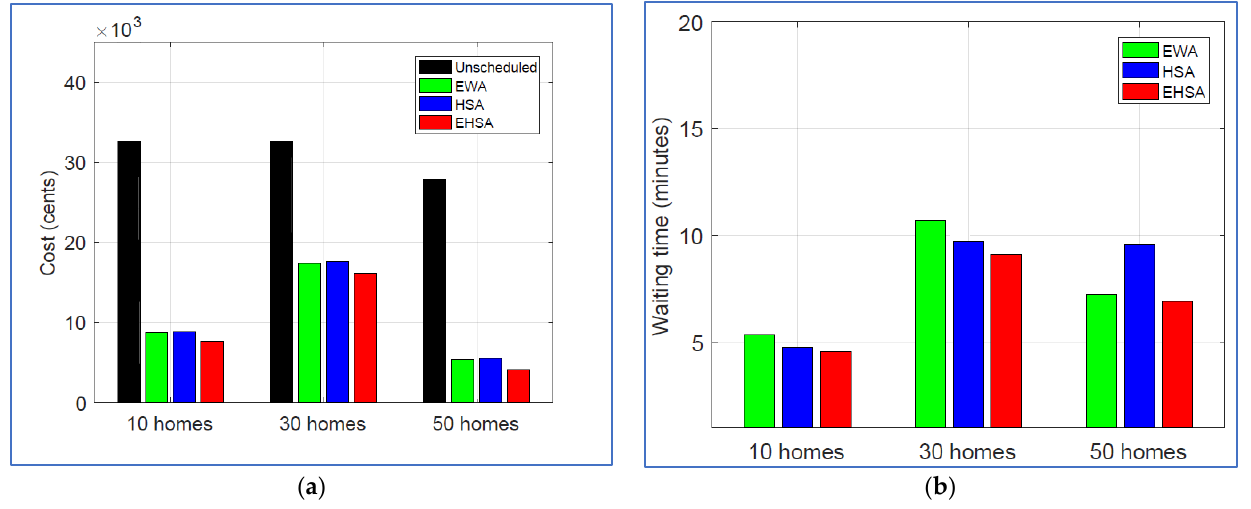
Figure 7. ( a ) Total Cost of 10, 30, 50 homes. ( b ) Waiting time of 10, 30, 50 homes.